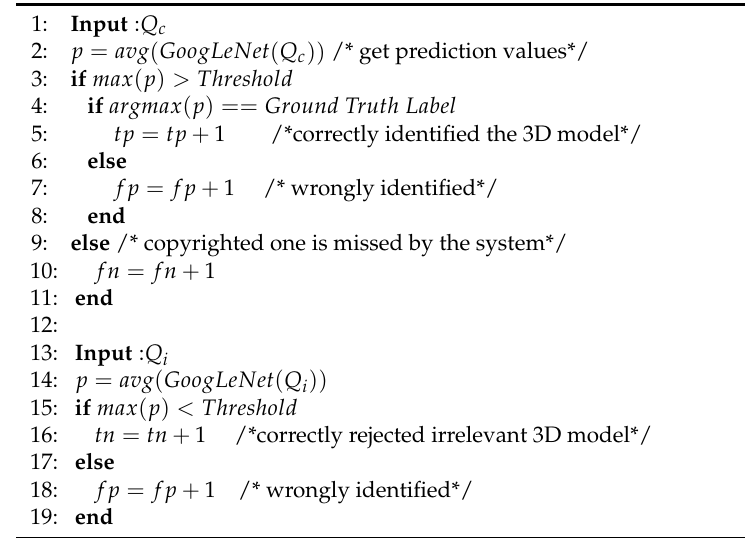
Table 2. Table of 3D model identification results with default settings and different